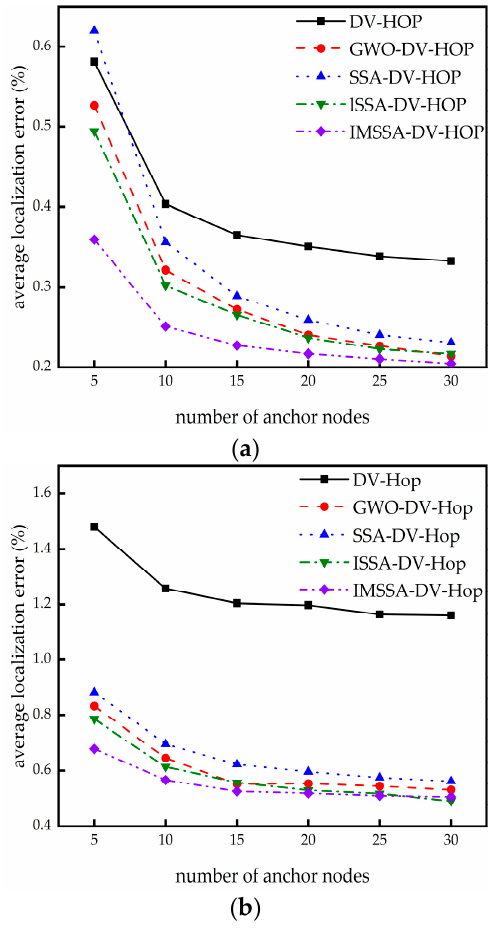
Figure 8. Localization error diagrams for different number of anchor nodes: ( a ) square random topology; ( b ) C-shaped random